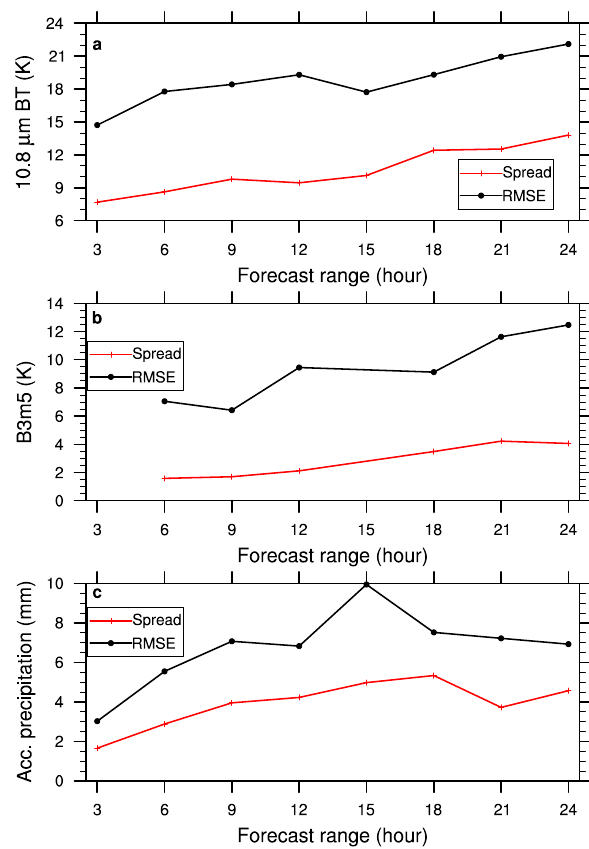
Fig. 12. Time series of spread and RMSE for (a) 10.8µm BT, Fig.12. Timeseries ofspread and RMSEfor(a)10.8 µ m BT,(b)B3m5 and (c)3-h accumulated precipitation. (b) B3m5 and (c) 3-h accumulated precipitation. Fields were cal- Fieldswere calculated over the domain shown in Fig. 8. culated over the domain shown in Fig.